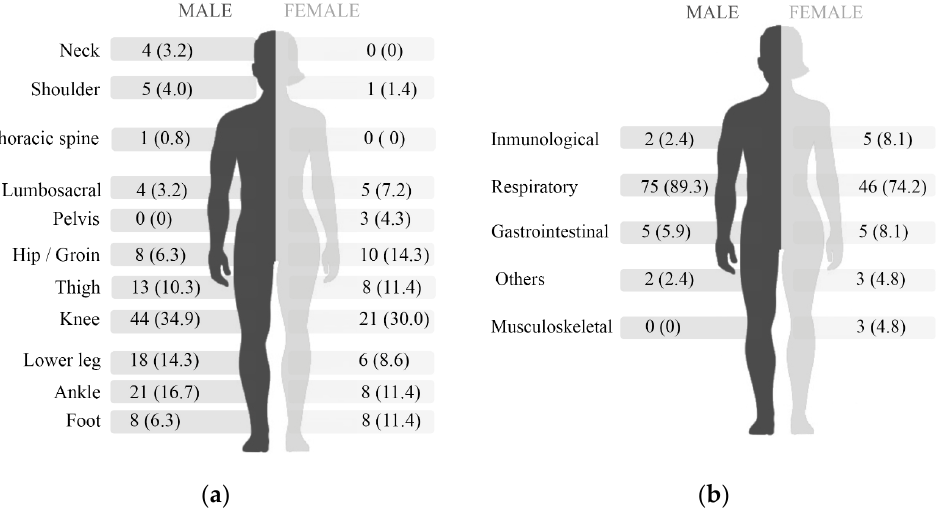
Figure 1. Anatomical region of ( a ) injury and ( b ) organ system affected by illnesses for males (values on the left) and females (values on the right).